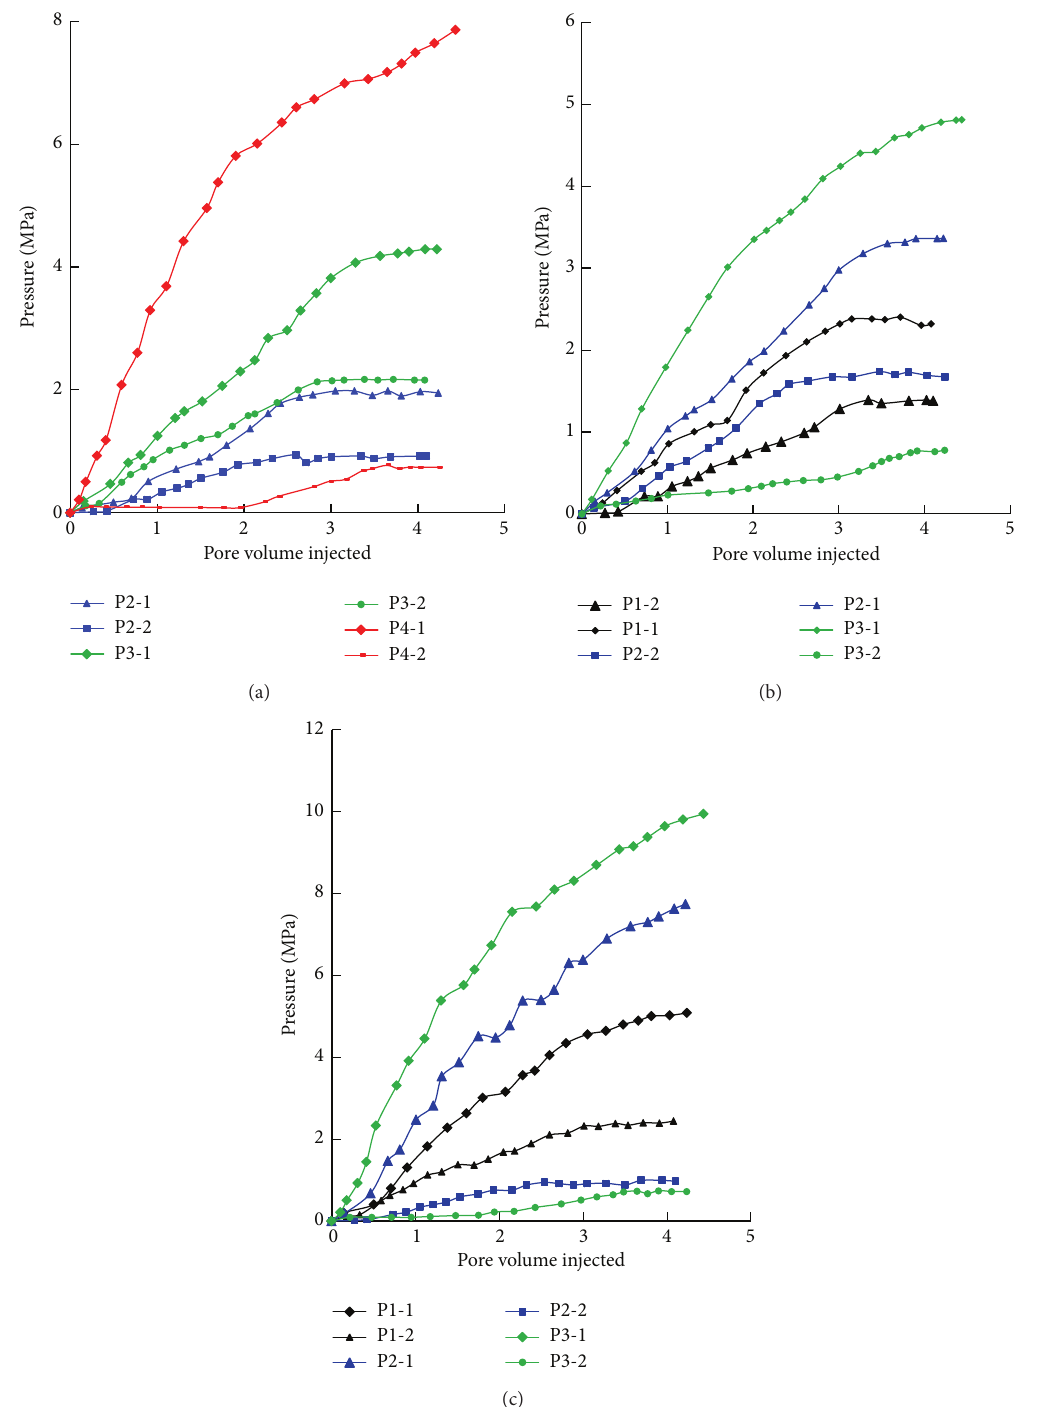
Figure 2: Injection pressures variation with injection volume of different polymer solutions ((a) Kg: 300 mD; (b) Kg: 180 mD; (c) Kg: 75